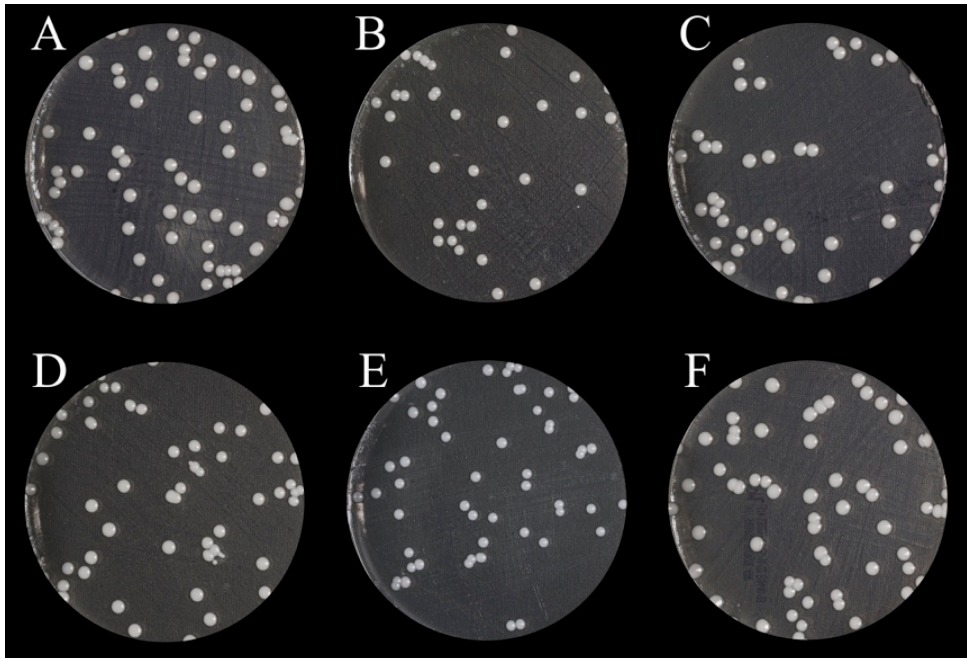
Figure 3. CFU images of the tested groups, showing the growth of adherent C. albicans in each group: ( A ) heat-polymerized PMMA, control group; ( B ) NextDent group with 0% ZrO 2 NPs; ( C ) NextDent group with 0.5% ZrO 2 NPs; ( D ) NextDent group with 1% ZrO 2 NPs; ( E ) NextDent group with 3% ZrO 2 NPs; ( F ) NextDent group with 5% ZrO 2 NPs.